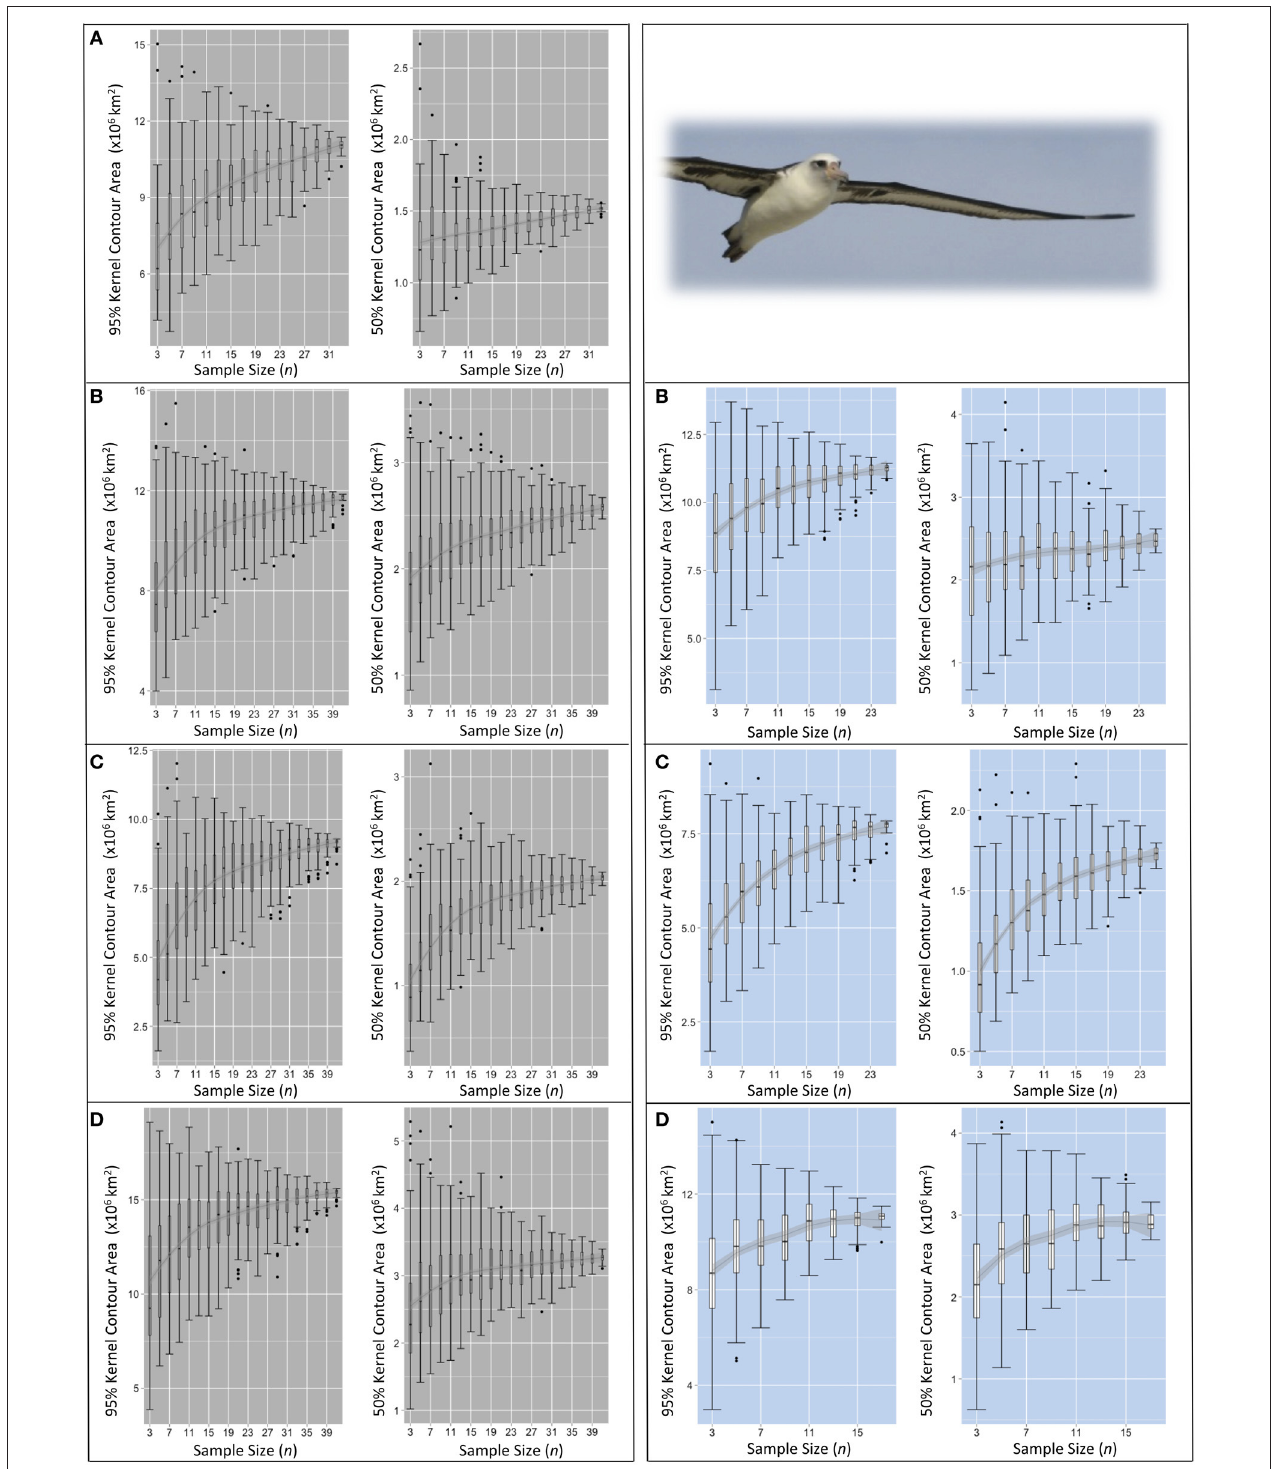
FIGURE 5 | Pooled KDE contour areas for Laysan albatross from two colonies during four periods of the annual cycle. Pooled KDE contour area (km 2 ) outputs for Laysan albatross from colonies at Midway (left panes in gray) and Tern (right panes in blue). Boxplots for each sample size (from n = 3 to n = max n –3) represent the 95 and 50% kernel contour areas of 100 iterations of KDE generated from the daily locations of n randomly selected individuals’ GLS tracks. The final boxplot in each panel depicts the results of KDE iterations of max n –1 (i.e., removing one individual from the dataset for each KDE), resulting in max n number of total iterations. Each set of four panes represent the four periods of the annual cycle: (A) ECR (insufficient data for Tern), (B) LCR, (C) OW, and (D) PBE (see Figure 1 ). LOESS smoothers are for visual interpretation and should be used only as a guide.